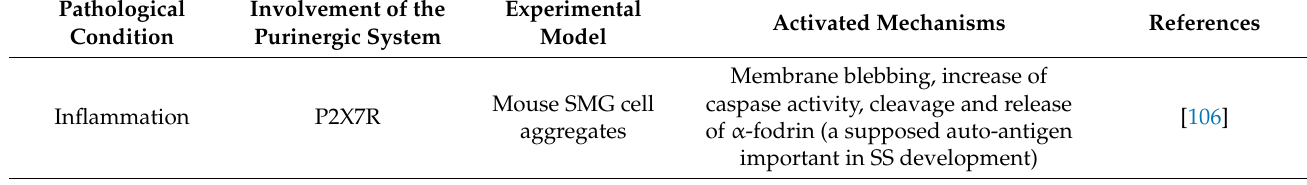
Table 2. Purinergic signaling in oral cavity